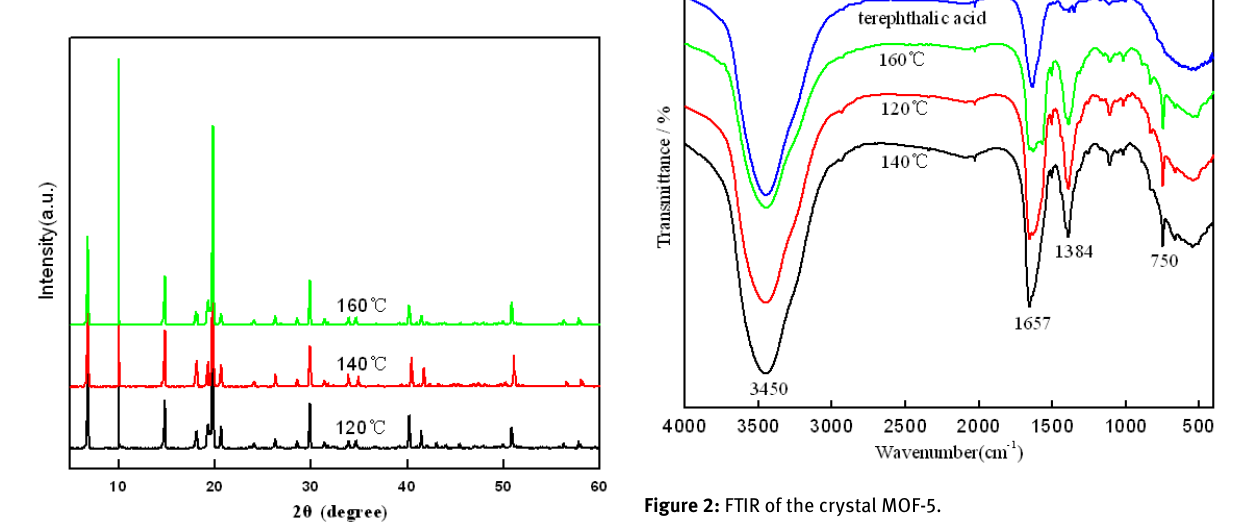
Figure 2: FTIR of the crystal